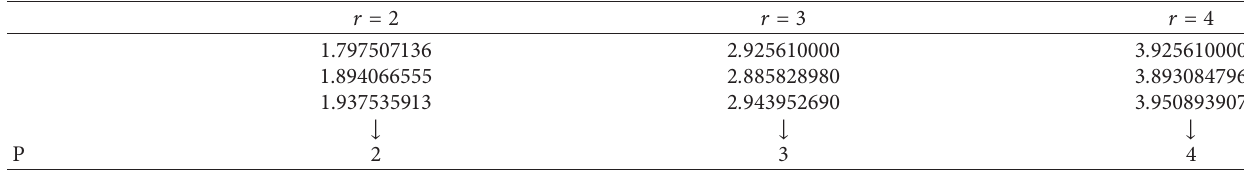
Table 5: Order of convergence for Example 2.